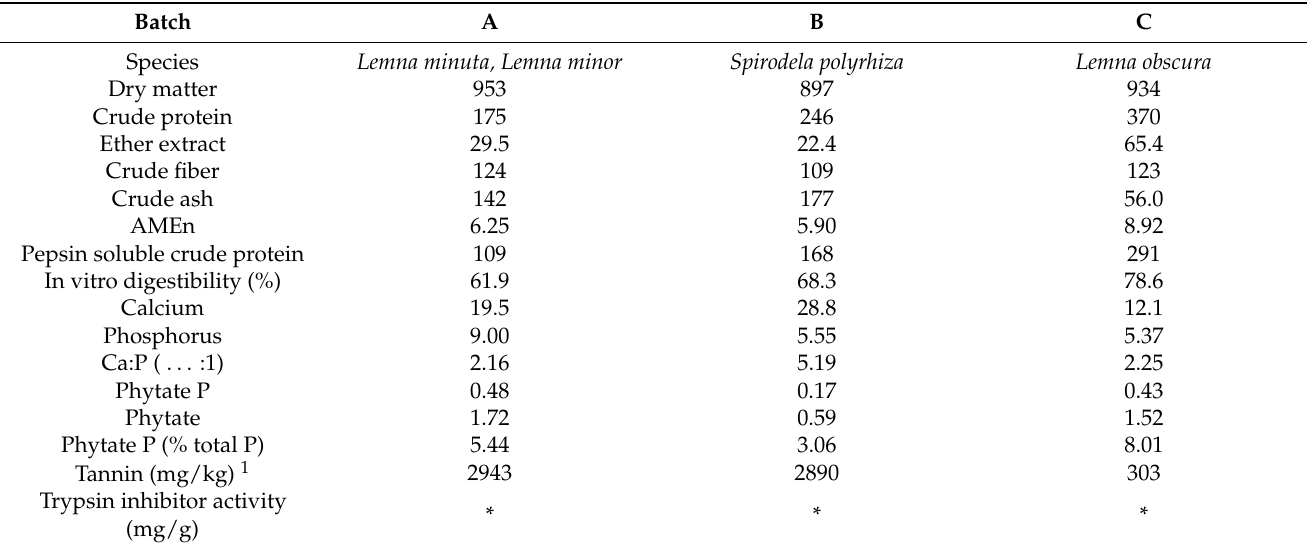
Table 1. Nutrient levels of dried duckweed (g/kg as fed except where